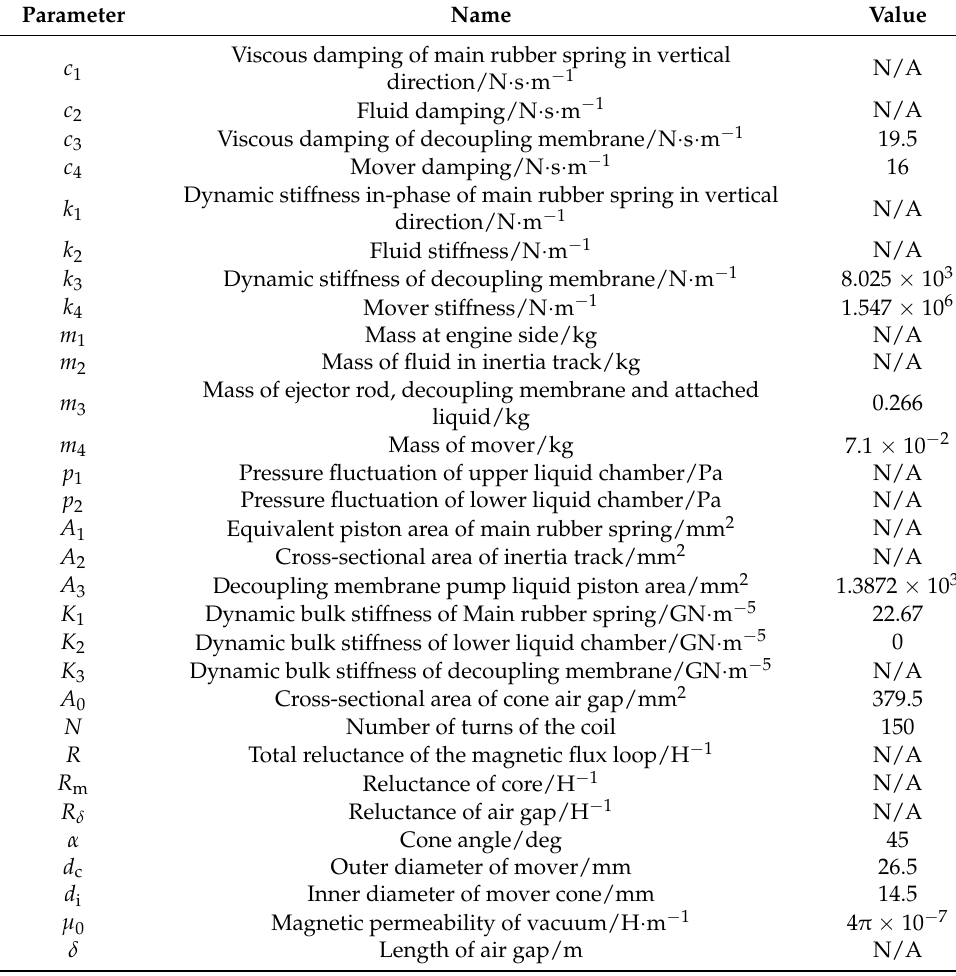
Table 1. Parameters for